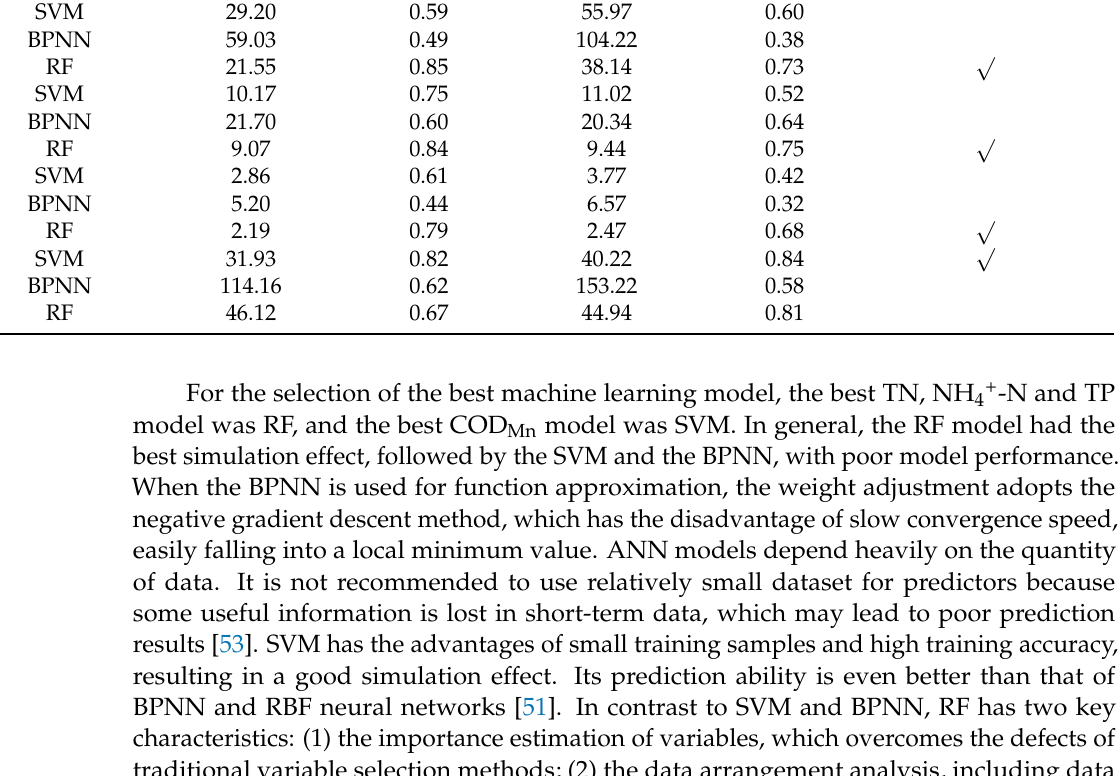
Table 7. Simulation results of runoff pollutant load calculated by the machine learning algorithm. Training Pollution Machine